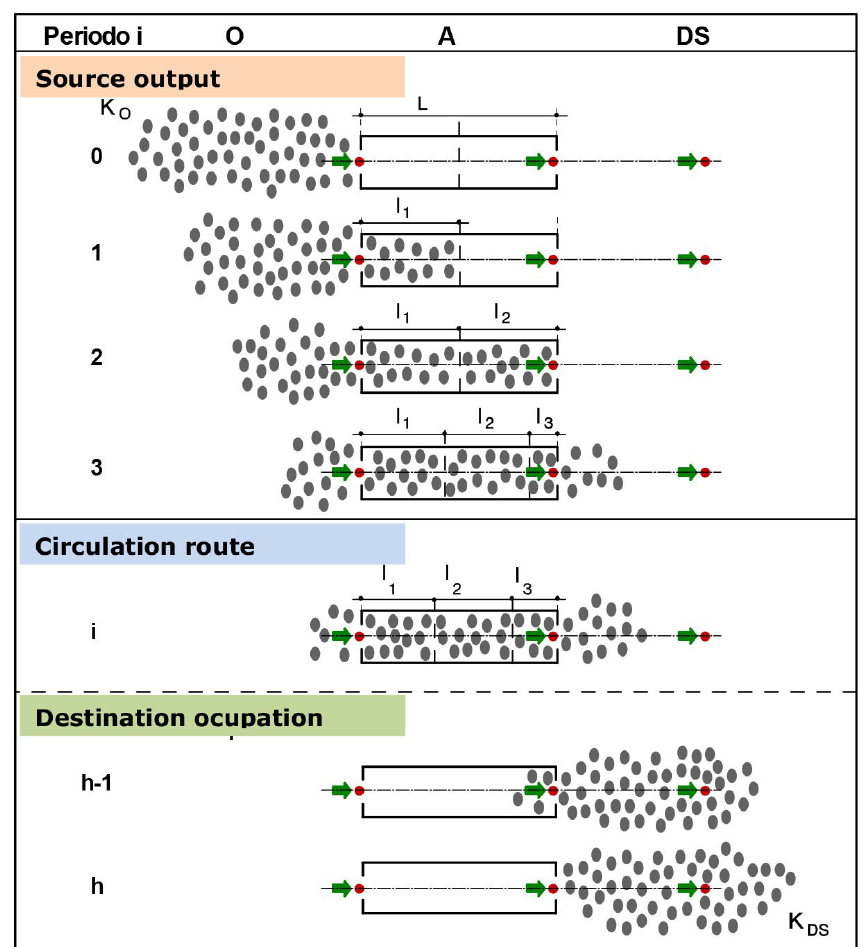
Figure 4. Descriptive analysis of the development of circulation in an evacuation